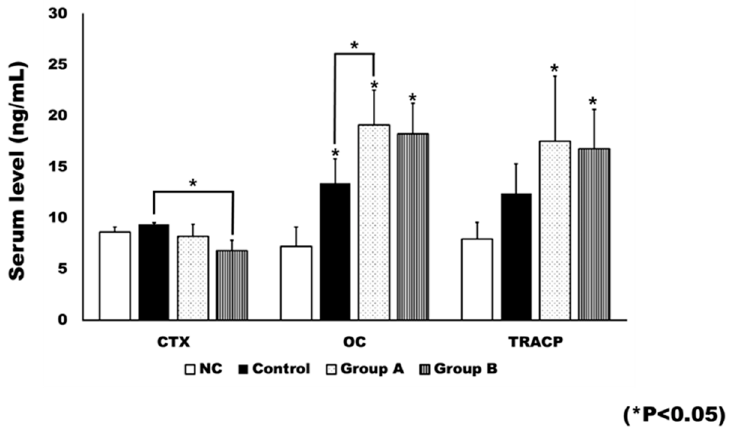
Figure 8. The plasma level of bone turnover markers. The level of c-terminal cross linking telopeptide (CTX) was generally decreased after 4HR treatment. The CTX level in Group B was significantly lower than that of the control (* p < 0.05). The level of osteocalcin (OC) was significantly increased after ovariectomy (* p < 0.05). In addition, 4HR administration further increased the OC level. When compared to the control group, Group A showed a significantly higher OC level (* p < 0.05). The tartrate-resistant acid phosphatase (TRACP) level was also increased after ovariectomy. When compared to the untreated control, both Groups A and B showed significantly increased TRACP levels (* p < 0.05).